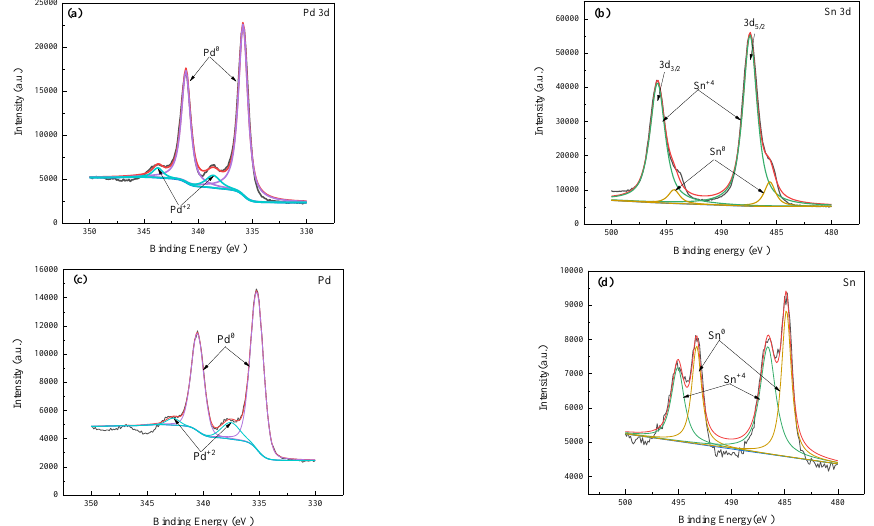
Figure 9. XPS spectra of top-surface of the sample after sensitization/activation process ( a ) and after acceleration process ( b ).